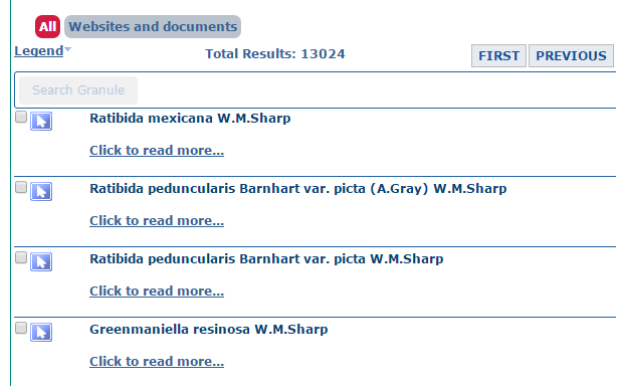
Figure 8. An example of searching WMS in GEOSS.